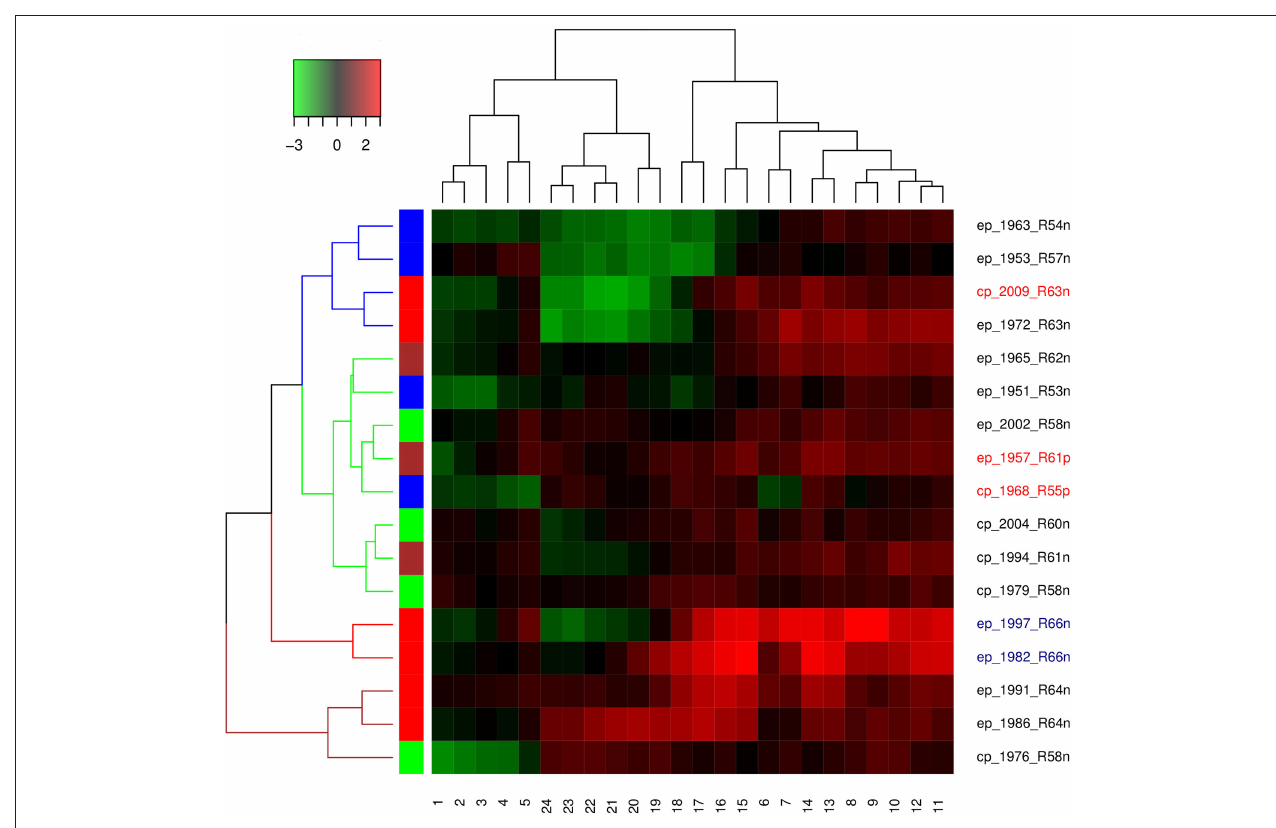
FIGURE 6 | Dendrogram and heatmap (MEI